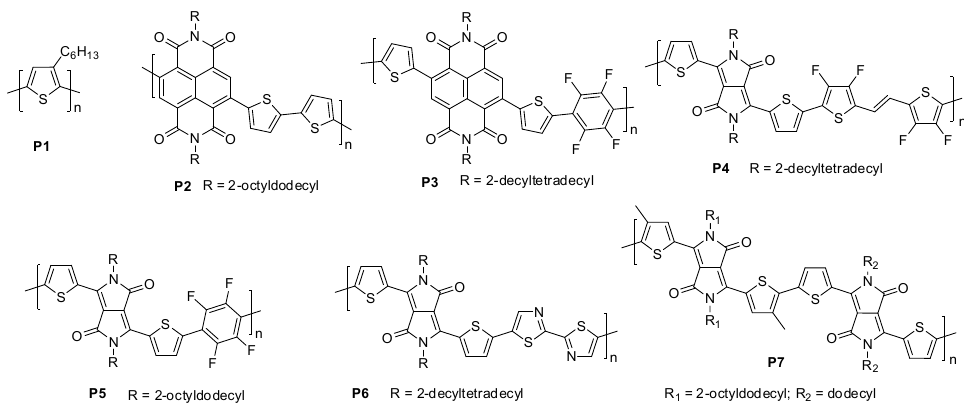
Figure 3. Polymers made using DHAP and conventional methods evaluated in organic thin film transistors (OTFTs).